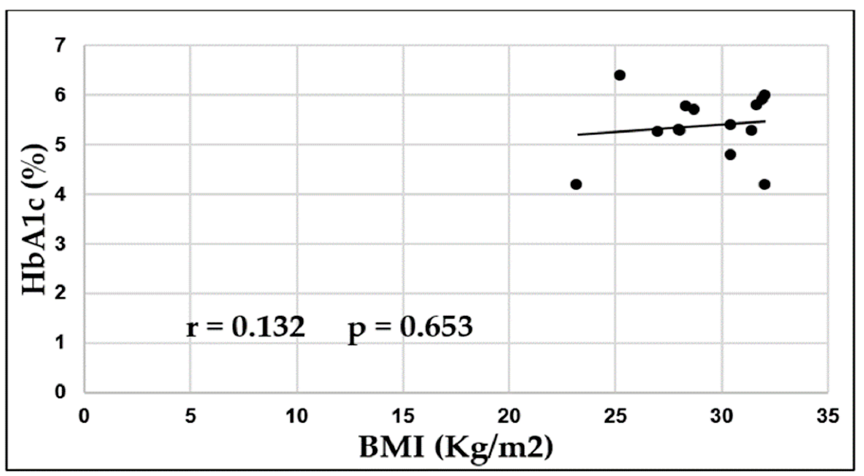
Figure 6. Pearson Correlation Coefficient (r) was calculated to analyze if there is a linear correlation between BMI (Kg/m 2 ) and HbA1c (%) among healthy individuals sweetener consumers. A positive correlation was found between the period of sweetener consumption and the levels of FSG (r = 0.22, p = 0.04) and serum TG (r = 0.262, p = 0.014) (Figure 7).